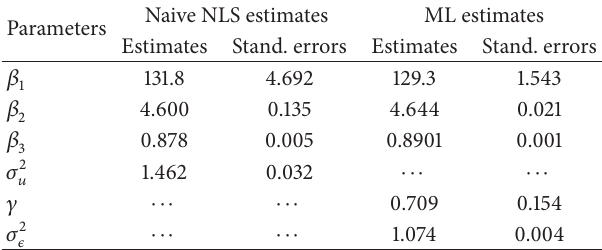
Table 2: NLS results with errors 𝑢 𝑡 ∼ 𝑖𝑖𝑑(0,𝜎 2 𝑢 ) and MLE results with MA(1) errors given by (35). Naive NLS estimates ML estimates Parameters Estimates Stand. errors Estimates Stand.